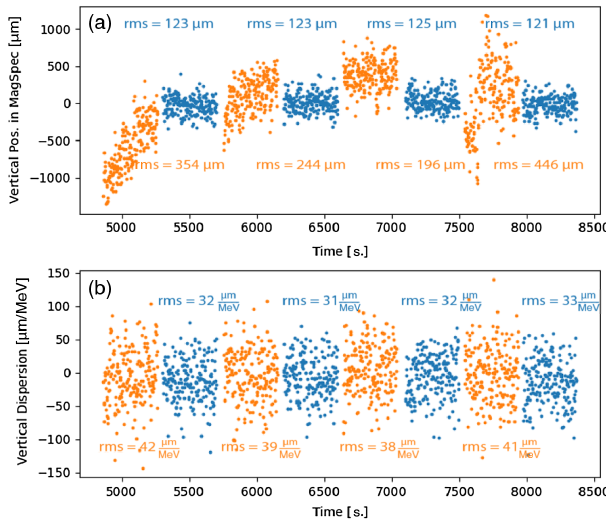
FIG. 3. Four sets of the feedback stabilization system on (blue) vs off (orange) and their corresponding e-beam source vertical position (a) and dispersion (b) in the magnetic spectrometer were measured. The integrated rms error with the feedback on vs off was 125 and 481 μ m for position, and 32 and 40 μ m = MeV for dispersion with the feedback on and off, respectively. We note that the active stabilization is reducing both shot-to-shot variation and long-term